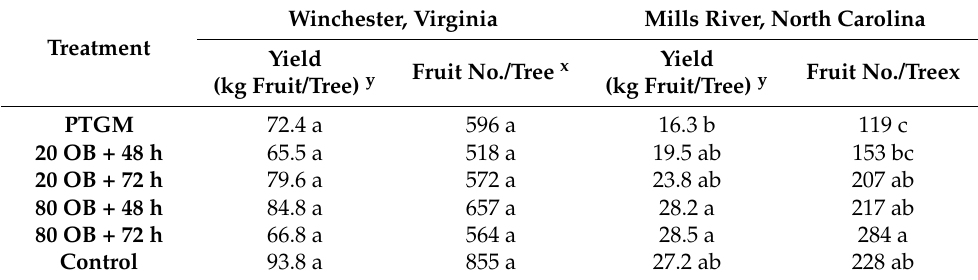
Winchester, Virginia Mills River, North Carolina Treatment Yield Fruit No./Tree x (kg Fruit/Tree) y